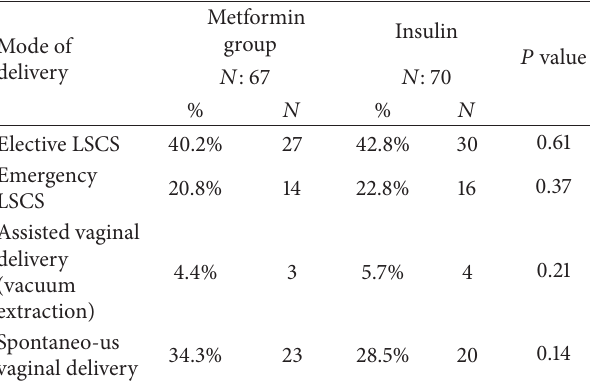
Table 4: Mode of delivery between metformin and insulin groups.